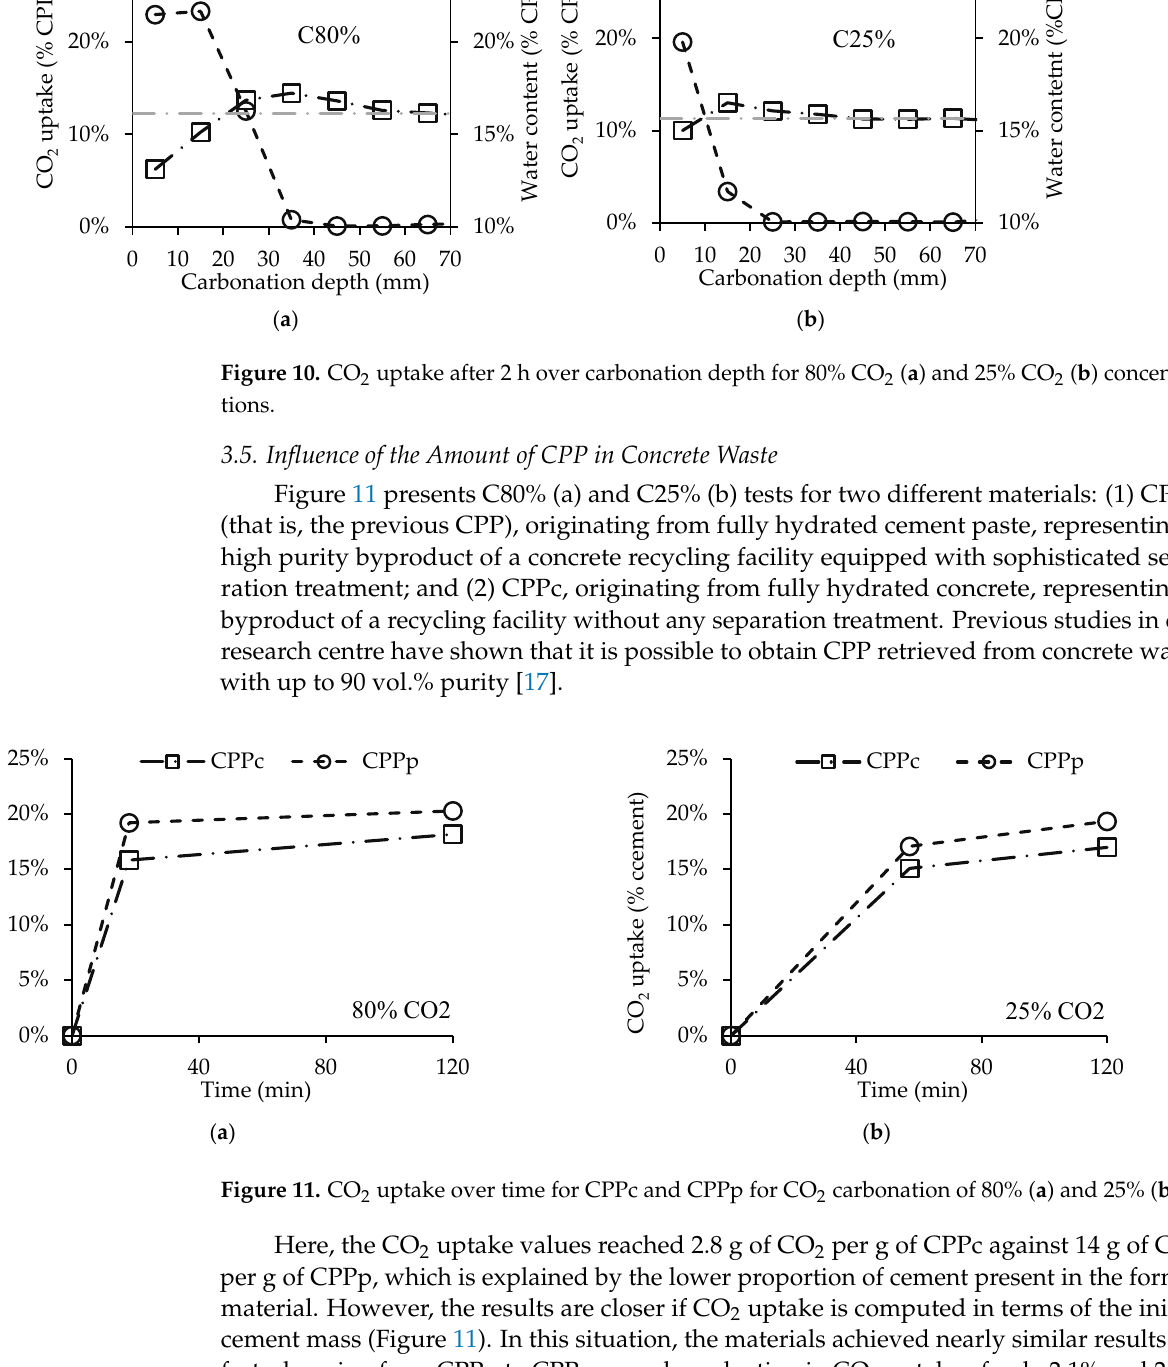
Figure 10. CO 2 uptake after 2 h over carbonation depth for 80% CO 2 ( a ) and 25% CO 2 ( b ) concentra- tions.